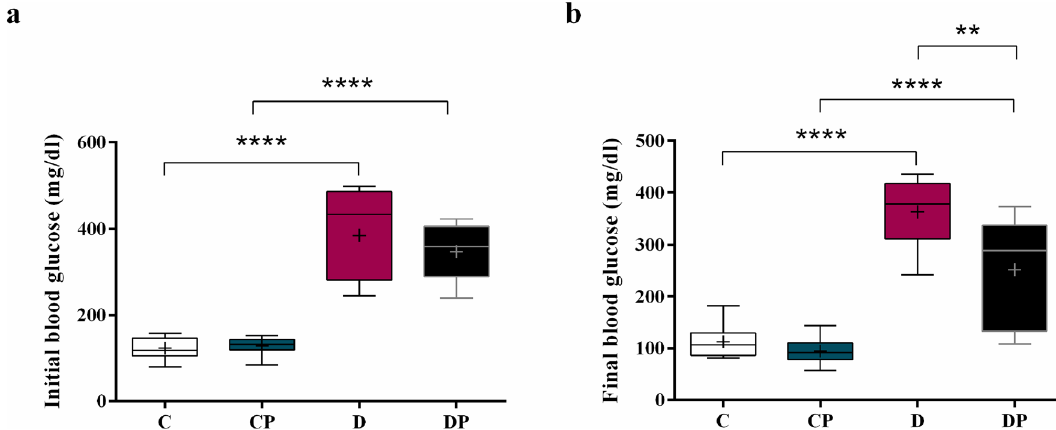
Figure 1. Fasting blood glucose in mg/dl (a) at the beginning and (b) at the end of the protocol (week 8). Control (C), control + probiotic (CP), diabetic (D) and diabetic + probiotic (DP) groups (n = 6–9/group). Data are from C57BL/6 STZ-induced diabetic mice, + /− Saccharomyces boulardii (0.5 × 10 8 colony-forming units, THT 500,101 strain , Probiotics and Starters Cultures, Belgium) for 8 weeks. A horizontal line inside the box indicates the median value of the samples within each group, and the upper and lower edges of the box